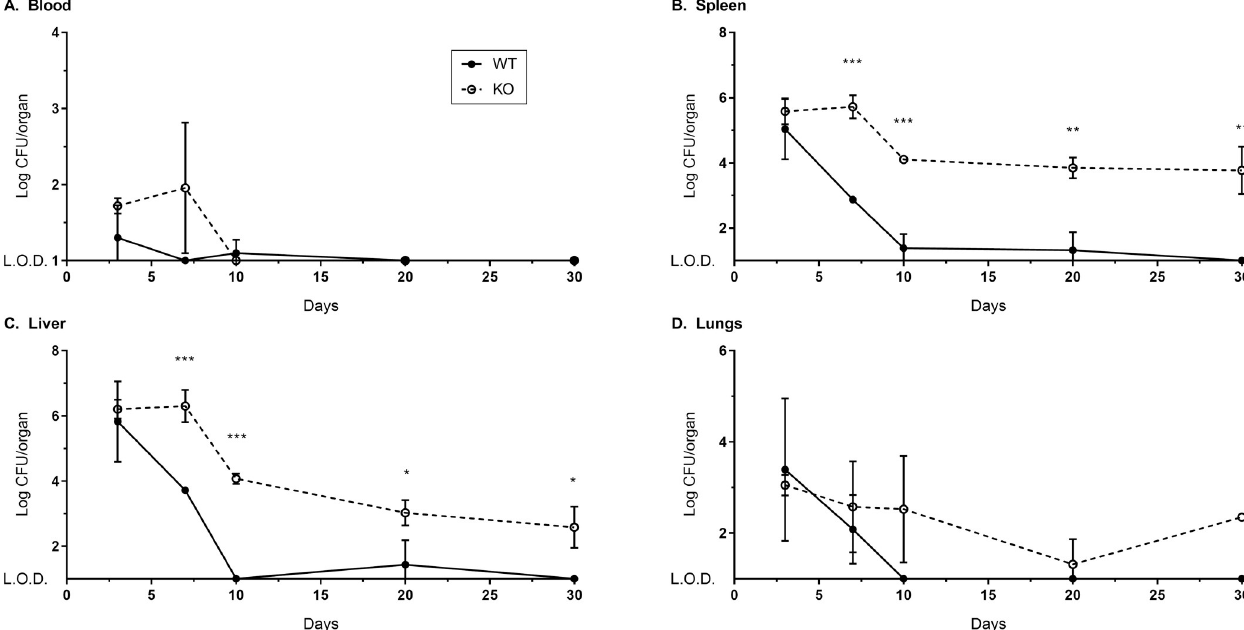
Fig 1. IL-12p40 KO mice maintain chronic LVS infection. Mice were infected with 10 5 LVS i.d. Three mice per group were sacrificed at 3, 7, 10, 20, and 30 days after infection to assess bacterial burden in blood, spleen, liver, and lungs. Data shown are from a representative experiment of three independent experiments. Mice used were ages 2–6 months and were aged matched within each experiment. � p < 0.05; �� p < 0.01; ��� p < 0.001 by Holm-Sˇı´da´k multiple t-test indicate differences between WT and KO samples at the corresponding time points.